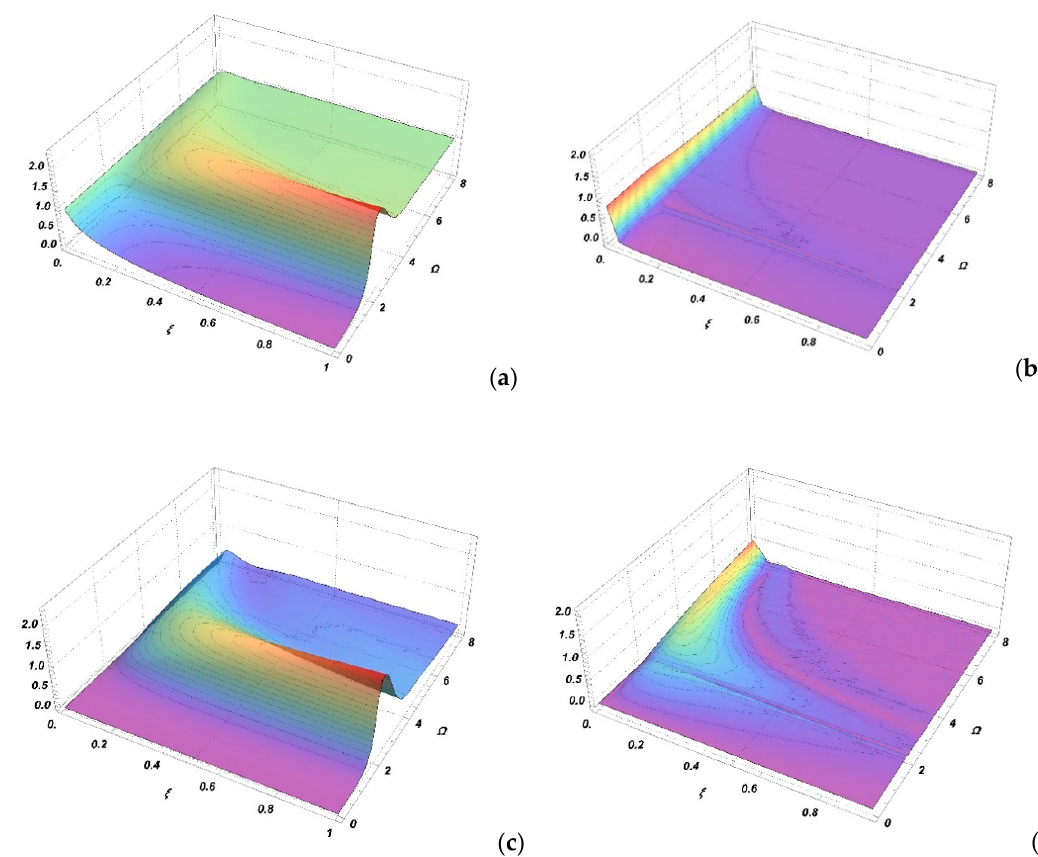
( , ) L ξ Ω as a function of the Massey L ξ Ω and Figure 1. Absorption spectra contributions ( , ) Figure 1. Absorption spectra contributions L d ( ξ , Ω ) and L int ( ξ , Ω ) as a function of the Massey parameter d int ξ and reduced frequency Ω are shown in ( a , c ). The di ff erences between these contributions and their parameter ξ and reduced frequency Ω are shown in ( a , c ). The differences between these ( ξ , Ω ) − L ( ξ , Ω ) and L a ( ξ , Ω ) − L ( ξ , Ω ) are shown in ( b , d adiabatic approximations L a ( , ) L ξ ξ Ω − Ω contributions and their adiabatic approximations ( , ) ξ Ω − Ω and int d int d int int are shown in ( b , d ).